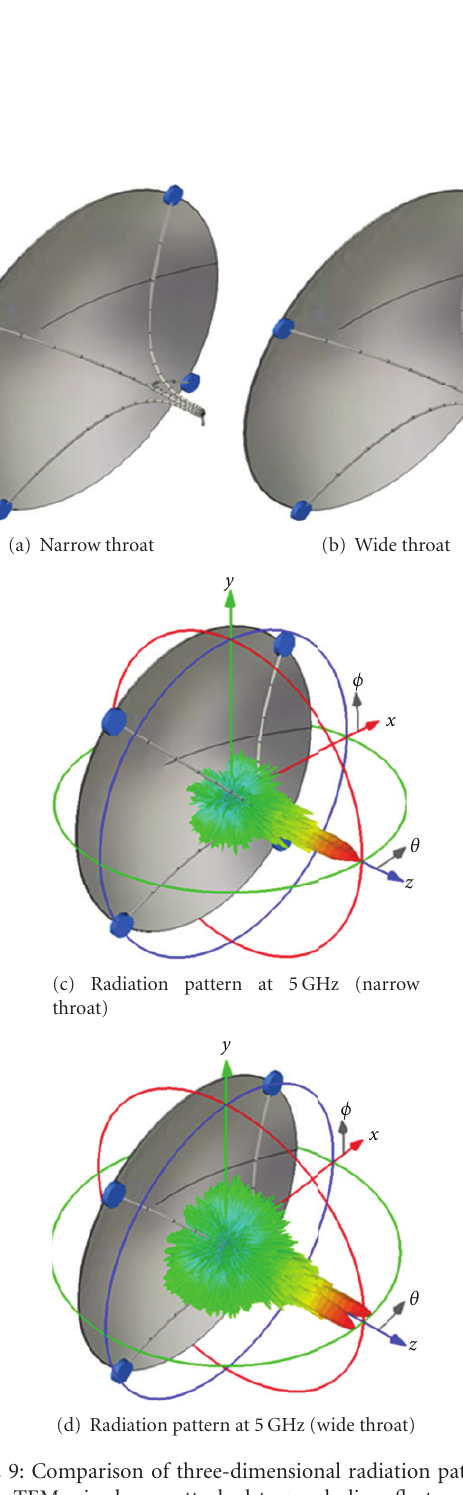
Figure 9: Comparison of three-dimensional radiation patterns of the two TEM-wire horns attached to parabolic reflectors. With a wide throat region, the main beam is split into two peaks due to asymmetry of the pattern of the TEM-wire